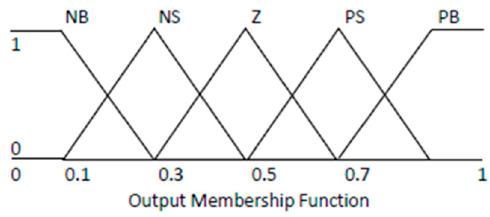
Figure 4. Output membership function.